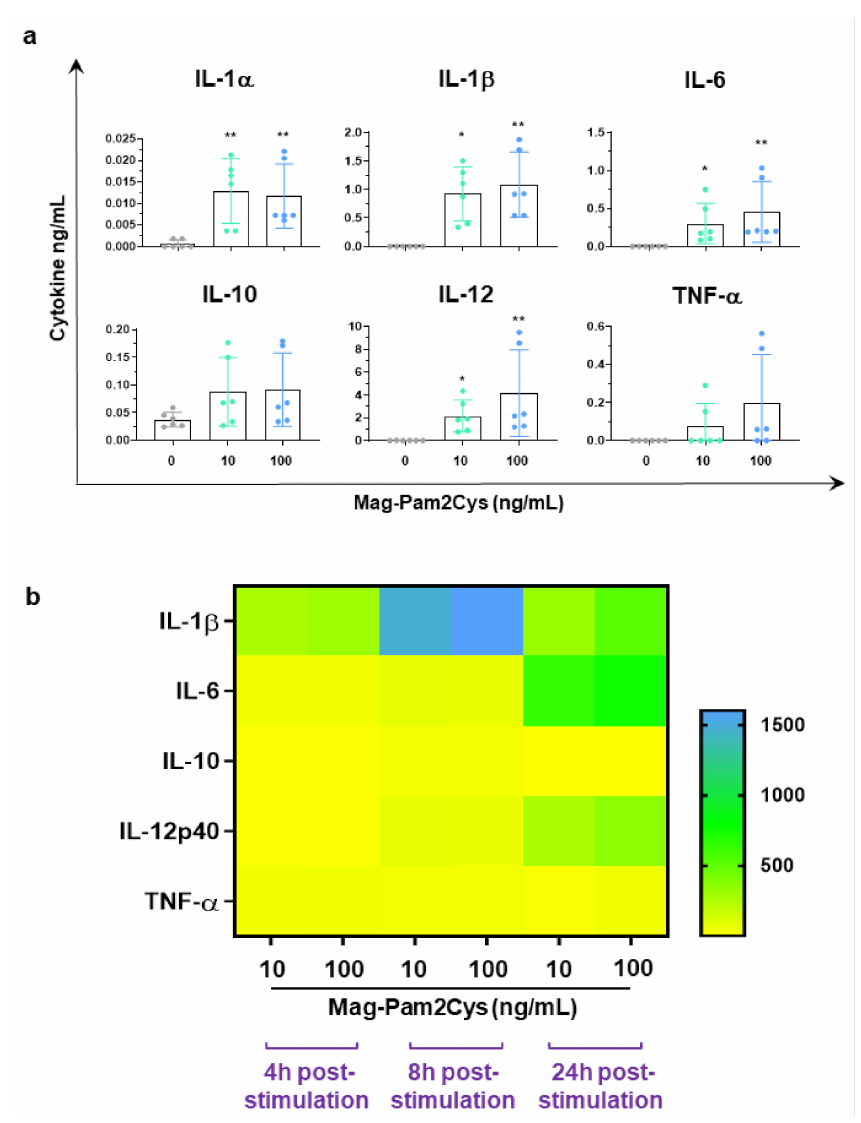
Figure 4. Mag-Pam2Cys’ impact on cytokine induction and release. Porcine moM Φ were left untreated or stimulated with scalar doses of Mag-Pam2Cys (10 or 100 ng/mL). ( a ) At 24 h post- stimulation, levels of IL-1 α , IL-1 β , IL-6, IL-10, IL-12, TNF- α in culture supernatants were quantified using a multiplex ELISA. Mean data and SD from three independent experiments using different blood donor pigs are presented. Values for Mag-Pam2Cys-stimulated samples were compared to the corresponding untreated control (moM Φ ) using a Kruskal–Wallis multiple comparison test; ** p < 0.01, * p < 0.05. ( b ) At 4, 8, and 24 h post-stimulation, gene expression levels of IL-1 β , IL-6, IL-10, IL-12p40, TNF- α genes were determined using RT-qPCR. At each time point, data were normalized on the values of untreated control and expressed as 2 − ∆∆ Cq , with ∆ Cq = Cq (target gene)—Cq (reference gene), and ∆∆ Cq = ∆ Cq (Mag-Pam2Cys-stimulated samples)— ∆ Cq (untreated sample, moM Φ ). Heatmap displays mean data from six independent experiments using different blood donor pigs. The colors in the cells represent the relative magnitude of gene expression. The green color represents the average magnitude of gene expression. The yellow color represents the smallest value, and the brightest blue represents the highest